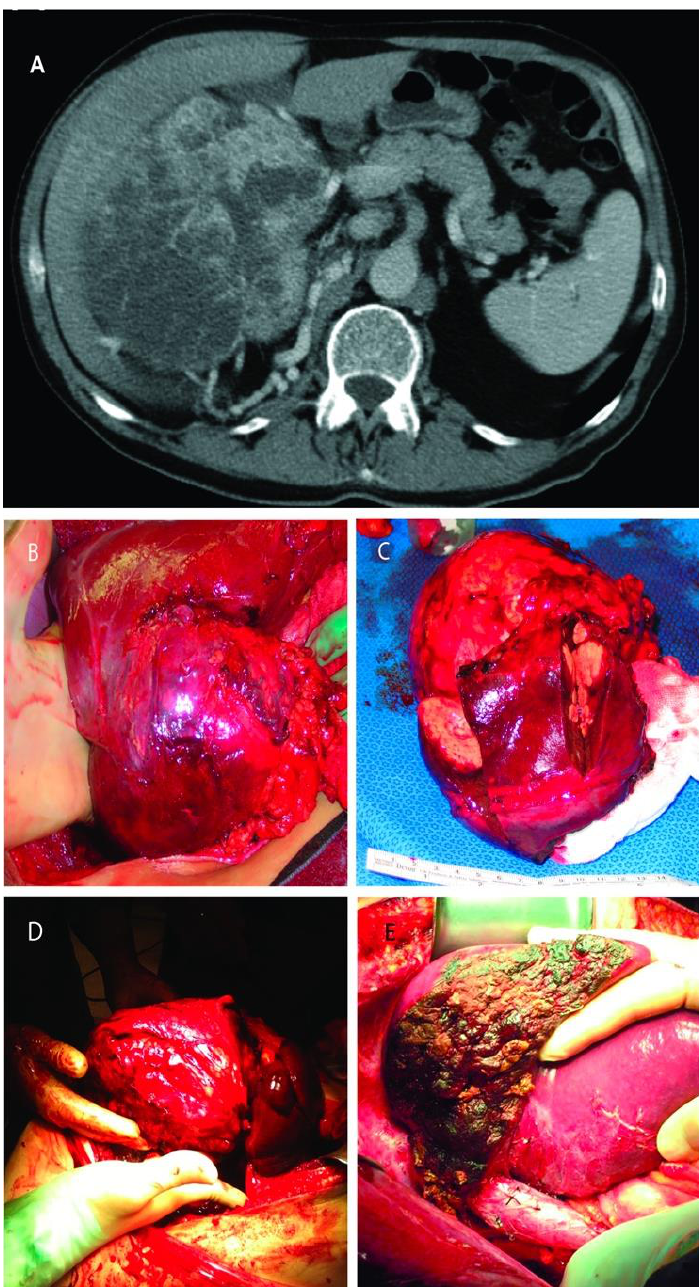
Figure 3. A: Computed tomography of large right renal mass with collaterals from the liver; B: Right renal mass with renal artery and vein ligated but still with blood flow from the liver; C: The resected specimens of right renal mass with right lobe of the liver; D: Right renal mass infiltrating the right lobe of the liver; E: Remaining liver after almost complete right lobectomy.